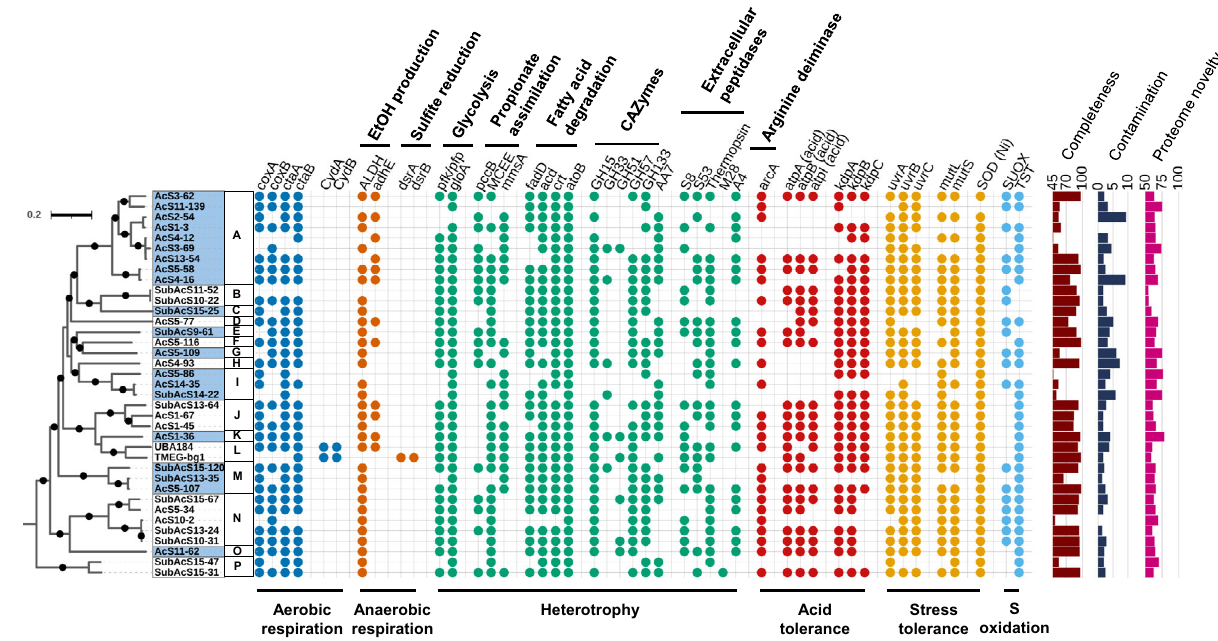
Fig. 1 Phylogenomic tree of Lutacidiplasmatales and associated metabolism. This tree includes 37 Lutacidiplasmatales genomes assembled from surface and subsurface soils (35 genomes obtained in this study and two published sequences). The tree was inferred by maximum likelihood from 738 concatenated phylogenetic markers, which were aligned separately and analysed using the best- fi tting model for each alignment. The tree was rooted with the Methanomassiliicoccales strains Methanoplasma termitum MpT1, Methanomethylophilus archaeon BRNA1 and Methanomethylophilus alvus Mx1201. Dots indicate branches with >95% UFBoot and SH-aLRT support. Intermittent blue and white colours on the leaf labels indicate the 16 known genera of Lutacidiplasmatales, as determined by an amino acid identity of 70% or greater. cox A (haem-copper oxygen reductases, subunit A; K02274), cox B (haem-copper oxygen reductases, subunit B; K02275), cta A (haem a synthase; K02259), cta B (haem o synthase; K02257), cyd A (cytochrome bd ubiquinol oxidase, subunit A; K00425), cyd